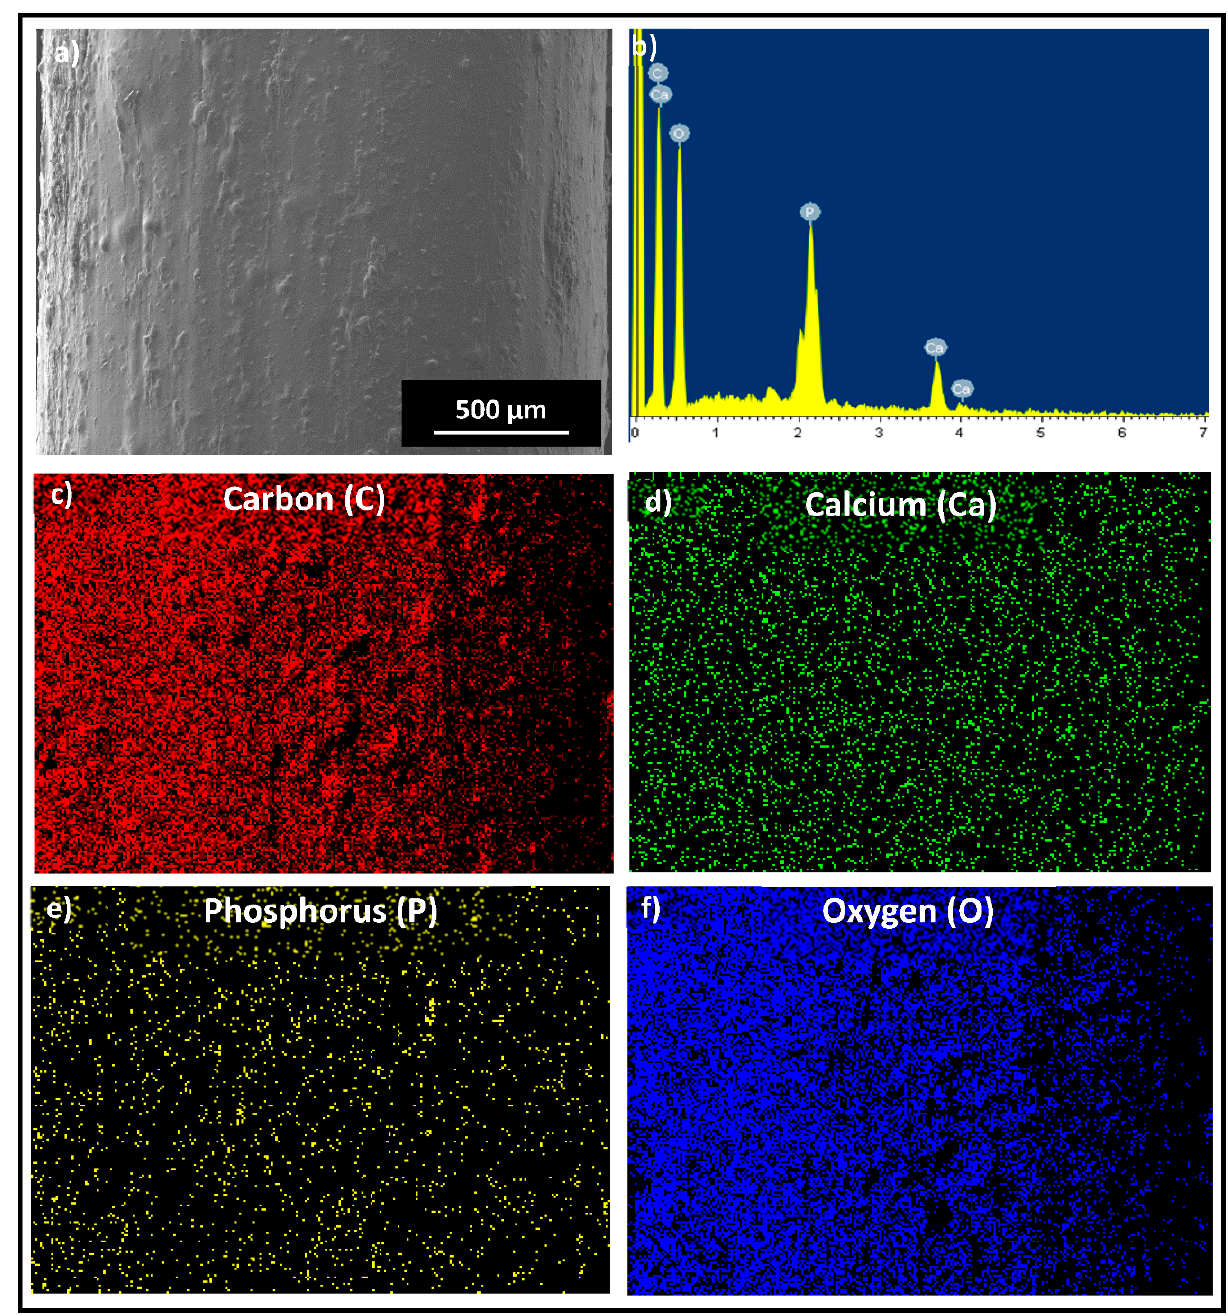
Figure 4. ( a )SEM high magnification image of TCP–PLA filament. ( b )EDX analysis of TCP–PLA filament. EDX element mapping of ( c ) Carbon, ( d ) Calcium, ( e ) Phosphorus, and ( f ) Oxygen. (The scale bar represents the actual length).